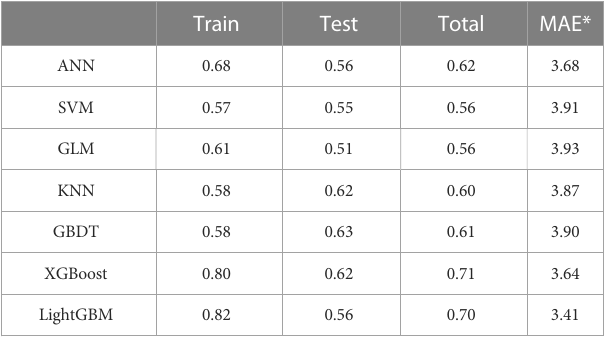
TABLE 2 Summary of prediction analyses for the training dataset (correlation value), the test dataset (correlation value), and the entire dataset (correlation value and mean absolute prediction errors value).